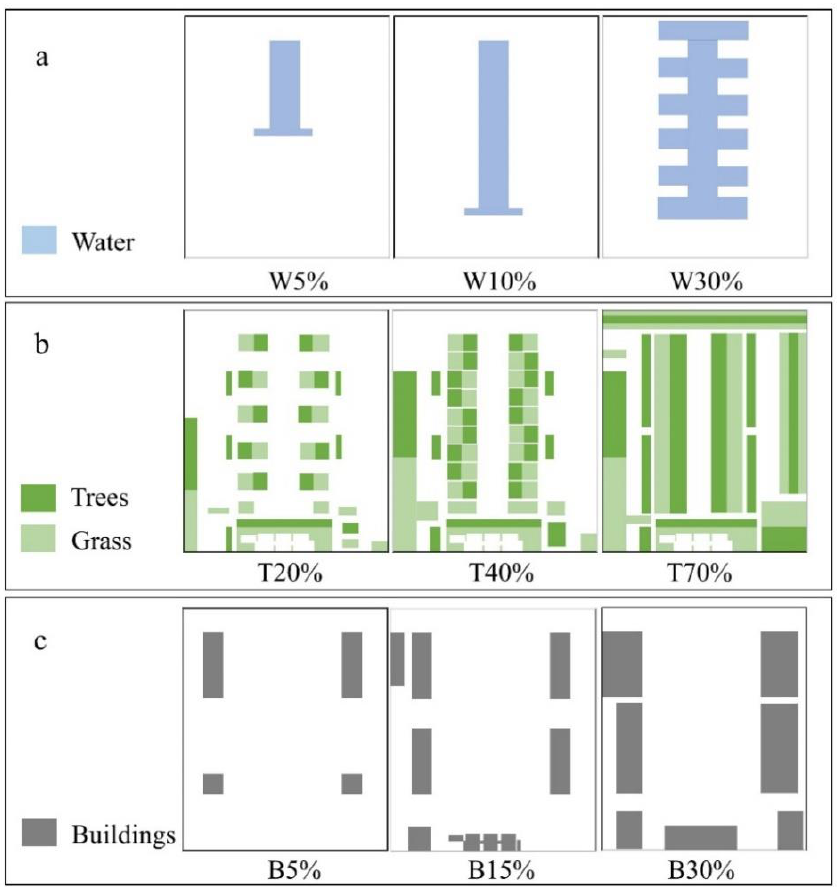
Figure 4. Redesigned scenarios of the ( a ) water bodies, ( b ) trees and ( c ) buildings of the